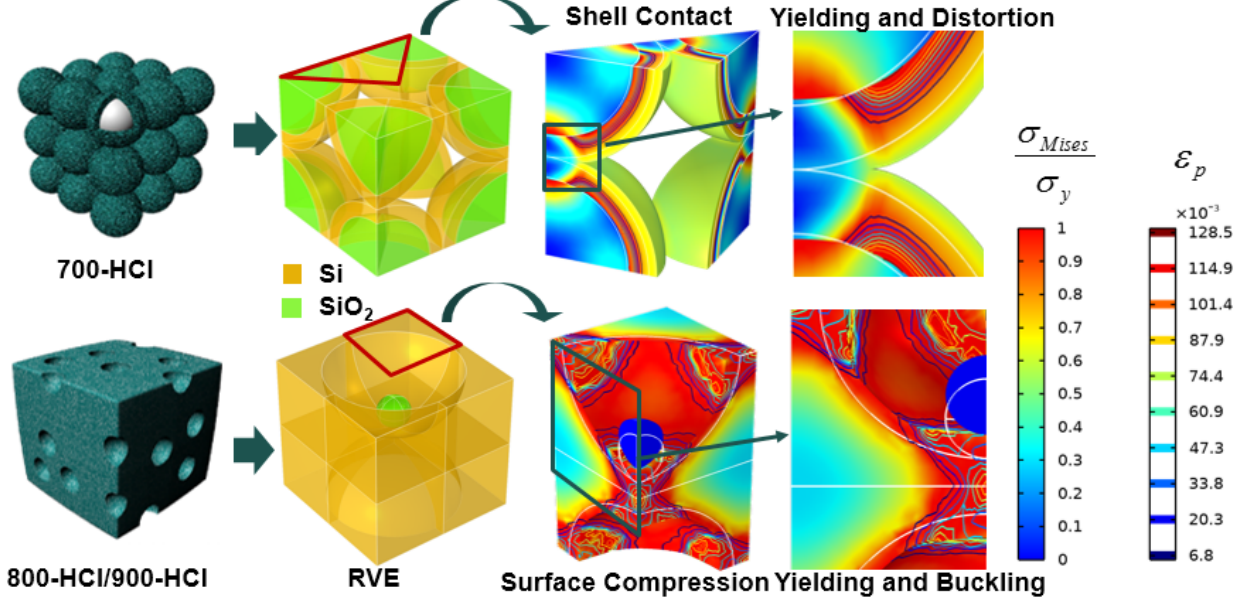
Figure 4. The representative volume element (RVE) and the corresponding distribution of dimensionless von Mises stress ( σ Mises / σ y ) and plastic strain ( ε p ) upon lithiation ( SOC =